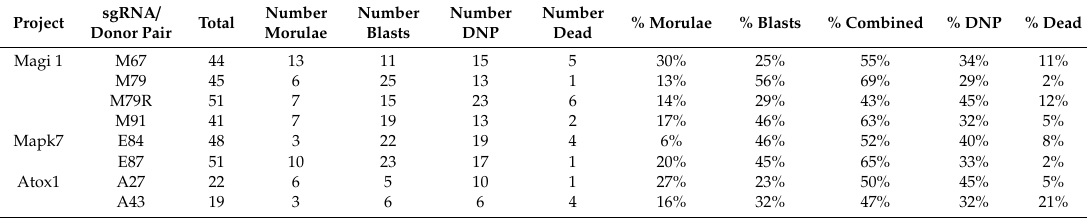
Table 1. Testing for sgRNA and donor DNA solution toxicity . Various sgRNAs and their paired DNA donors were tested for the three projects, Magi1 , Mapk7 and Atox1 . The results indicate that for Magi1 , sgRNAs-M79R and –M67, and for Atox1 , sgRNA-A43, the guide and / or donor solutions were detrimental to embryo progression. Total: total number of zygotes injected; Blasts: blastocysts; DNP: did not progress to the late morula / blastocyst